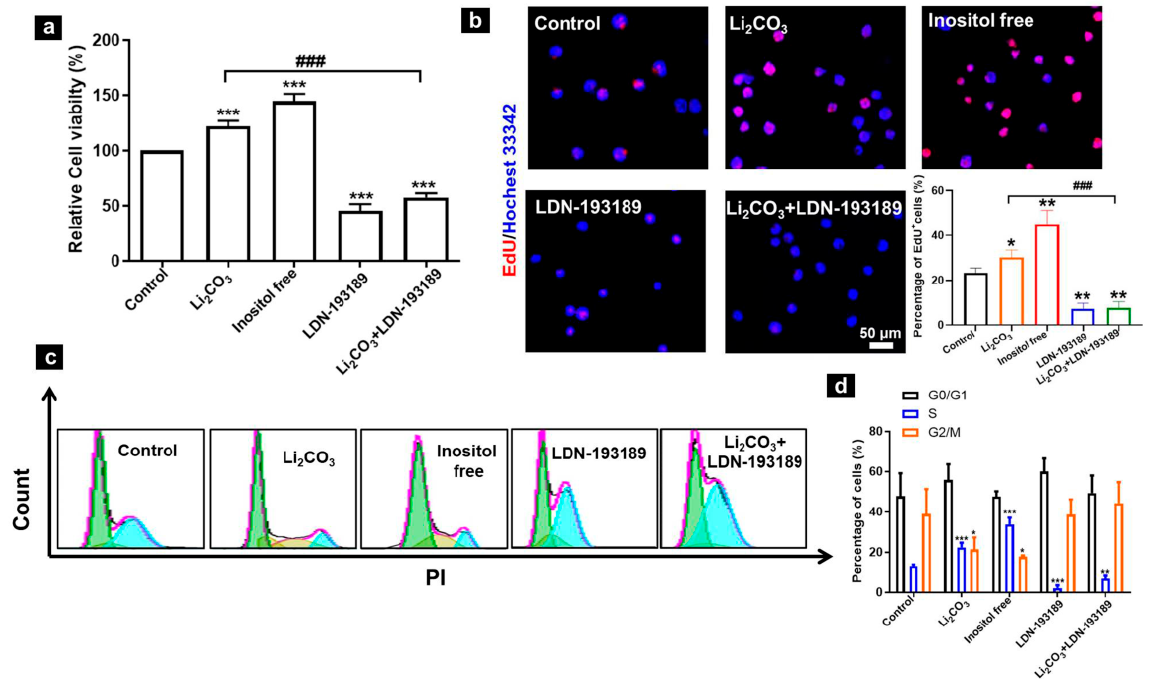
Figure 5. Role of BMP/Smad signaling in the regulation of cell proliferation in mNSCs. ( a ) MTT assay (n = 6). ( b ) EdU incorporation assay showing the percentages of EdU-positive cells (red). Nuclei were visualized with Hoechst 33342 (blue) and analyzed with fluorescent microscopy. Scale bar = 50 µ m. ( c ) Representative cell-cycle analysis performed with flow cytometry. ( d ) Percentage of cells in each phase. Data represented as mean ± SD (n = 3; * p < 0.05, ** p < 0.01 and *** p < 0.001 vs. control group; ### p < 0.001, comparison between the Li 2 CO 3 and Li 2 CO 3 + LDN-193189 groups).